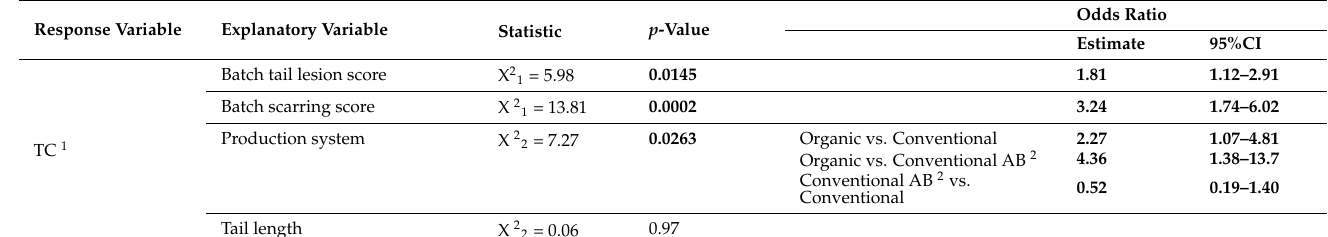
Table 3. Logistic regression model exploring batch-level variation in the occurrence of total con- demnations in pigs’ batches ( n = 73) at the slaughterhouse. For significant variables, odds ratio estimates (OR) and their 95% confident intervals (CI) are presented, with estimates for continuous scores calculated for a 0.5 unit increase. Significant p -values and ORs are highlighted in bold.